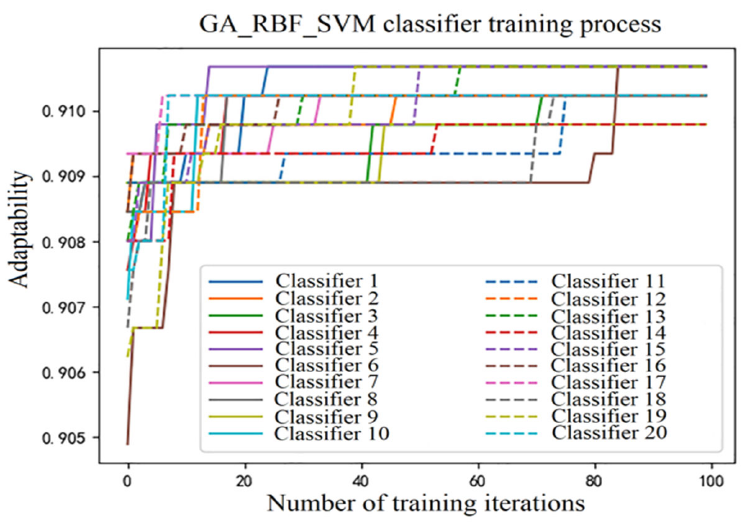
Figure 8. The variation curve of the highest fitness of all individuals of each base classifier during the training process of each of the 20 base classifiers.